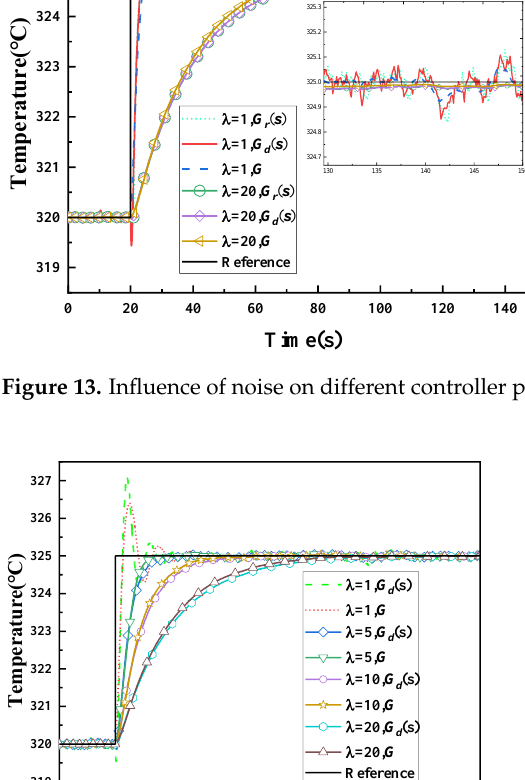
Figure 13. Influence of noise on different controller parameters.